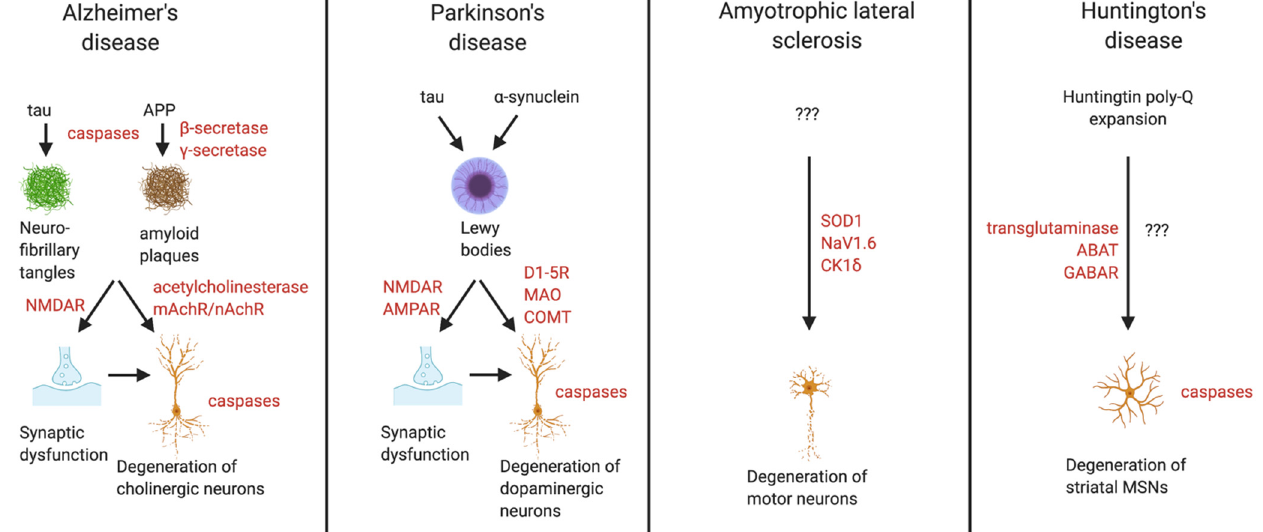
Figure 2. Overview of molecular mechanisms and drug targets (red text) in Alzheimer’s, Parkinson’s, ALS, and Huntington’s diseases. Figure made using Biorender.com, accessed on 28 April